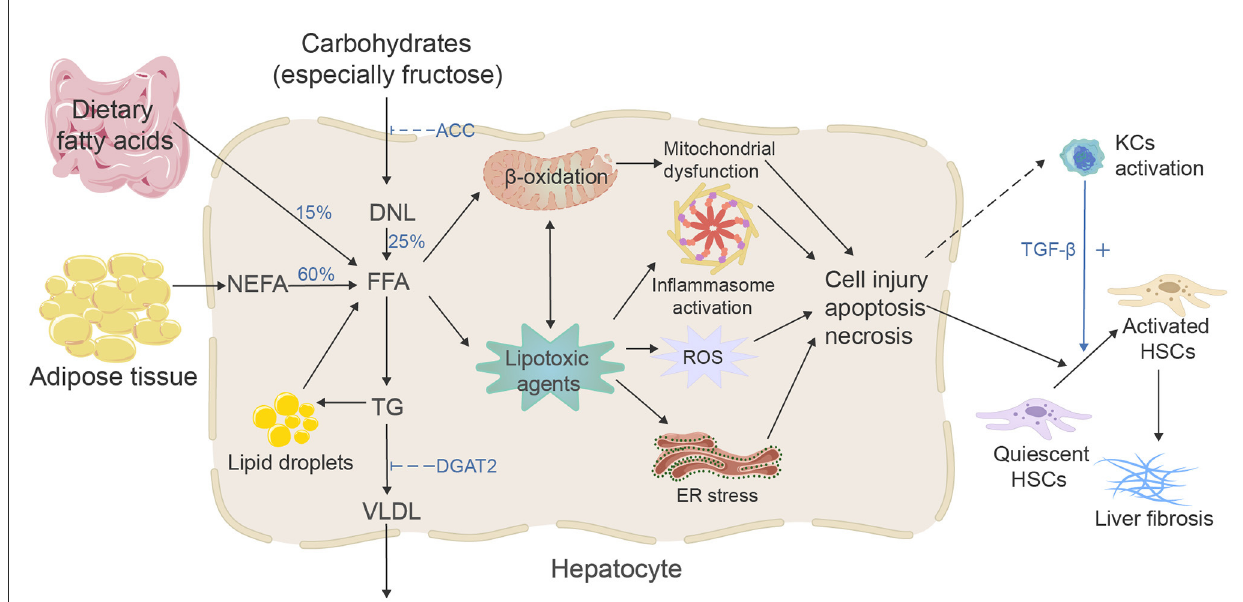
FIGURE1 Mechanisms of MAFLD-related liver fibrosis. Free fatty acids (FFAs) and their metabolites may represent the lipotoxic agents that induced the development of MAFLD, and the increasing concentration of FFA is considered the most critical stage. There are three primary sources and two fates of hepatic FFA. Excessive FFA and their metabolites will cause mitochondrial dysfunction, stimulate ER stress, oxidative stress, and inflammasome activation, then activate the HSCs and eventually lead to liver